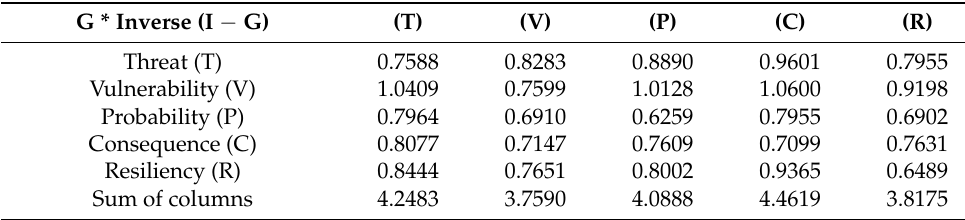
Table A3. Multiplication of the matrix G by the inverse matrix ( I − G ) − 1 .